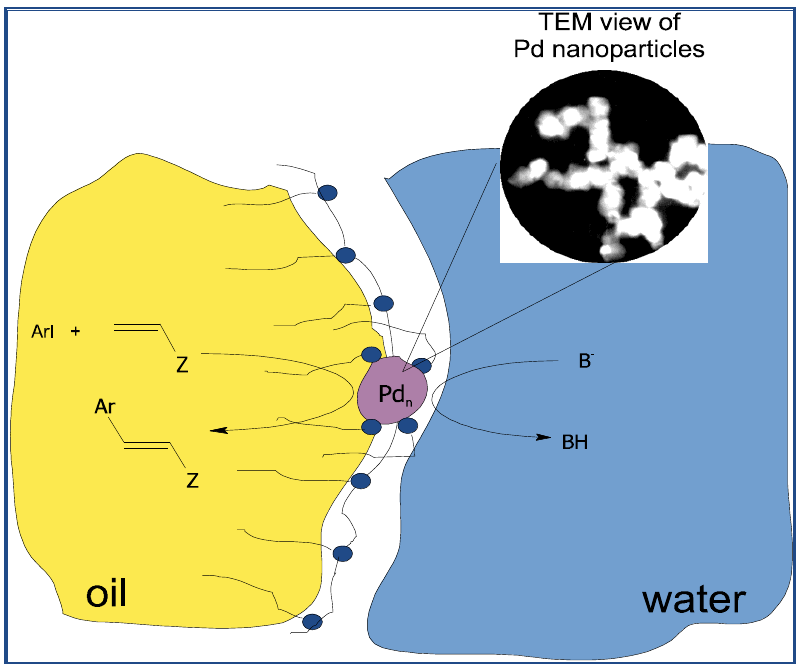
Figure 1. PdNPs in a microemulsion.